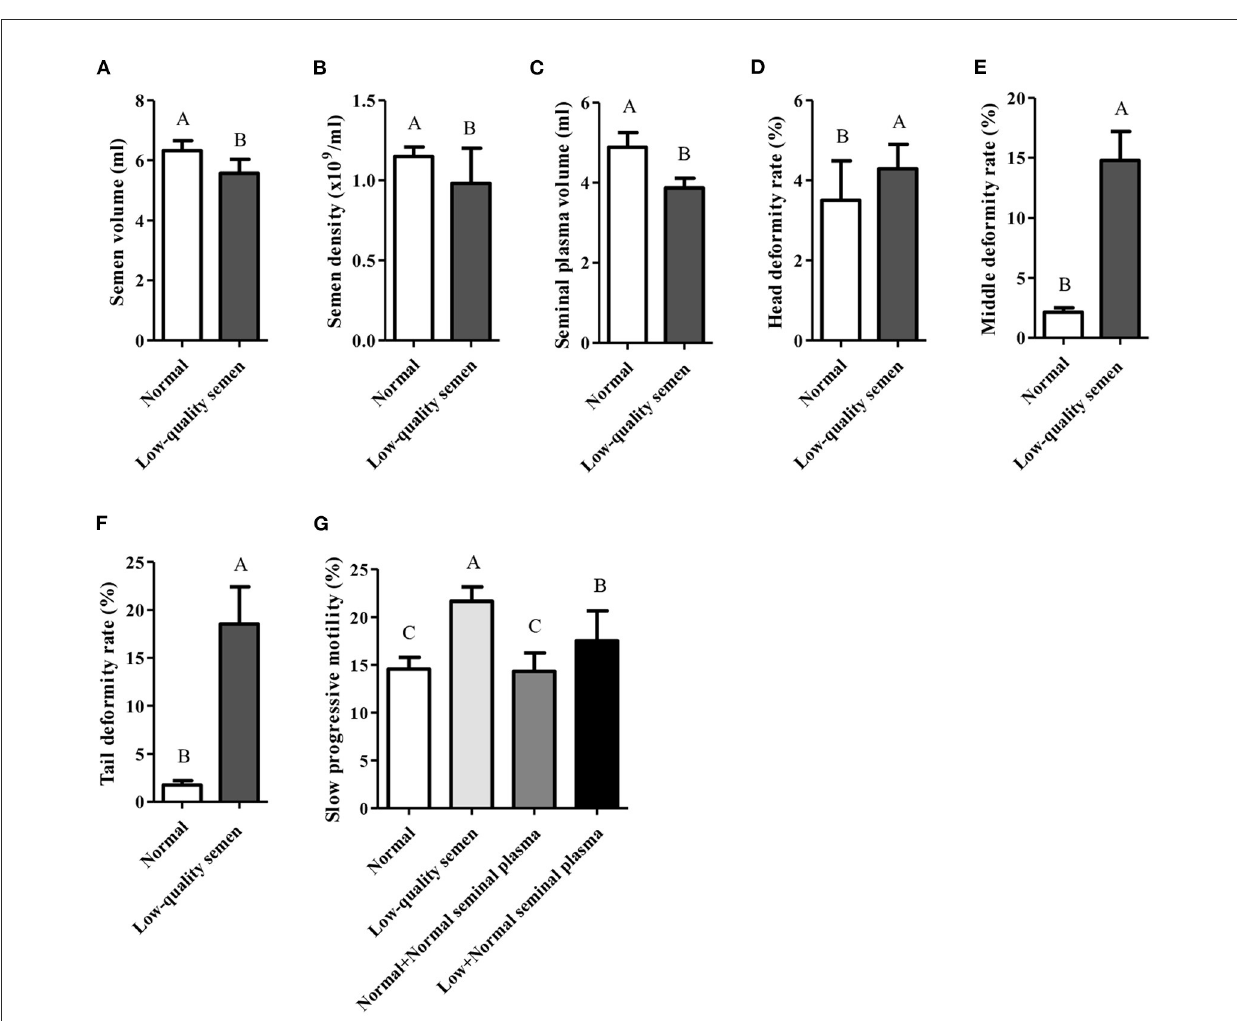
and Supplementary Table 5). Pathways with higher